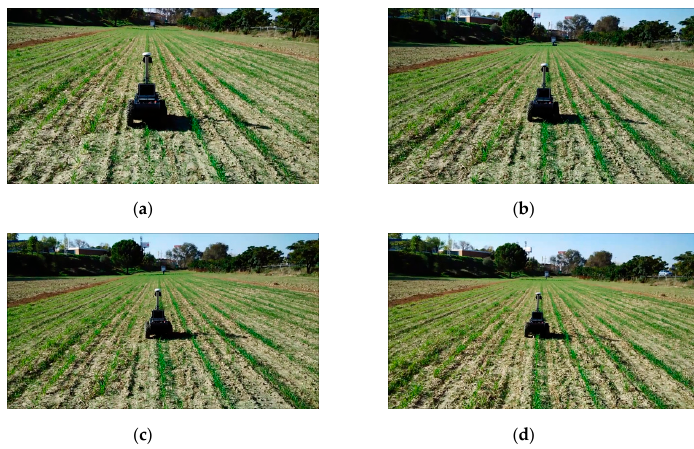
Figure 18. Crop row tracking behaviour. Images from ( a ) to ( d ) show a sequence of different frames of the video available in [65].